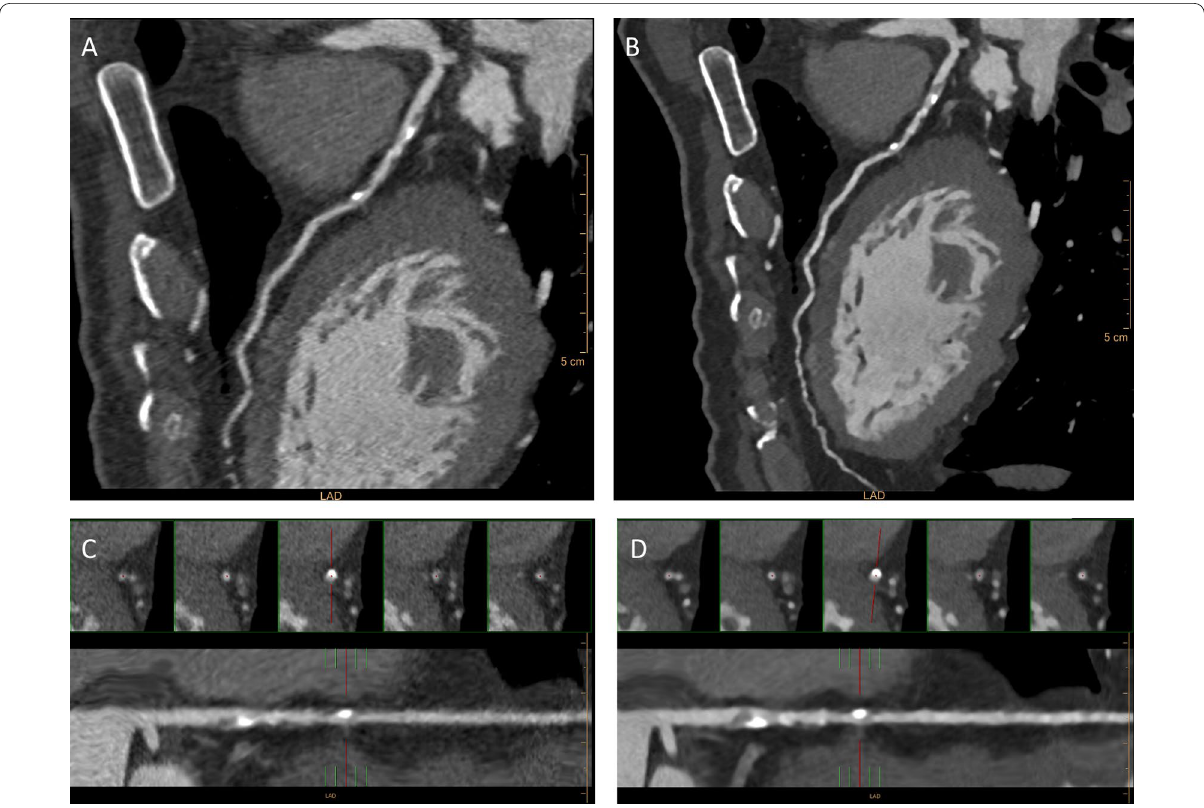
Fig. 4 Evaluation of left anterior descending coronary artery of a single patient with both IR ( a and c) and MBIR ( b and d) reconstruction algorithm. The MBIR reconstruction better depicts the artery wall and the lesions in comparison with IR images because of lower image noise. a–b Curved reconstruction of the LAD artery showing multiple mixed atherosclerotic plaques in the proximal and intermediate tract. New model-based iterative reconstruction (MBIR) is also possible to evaluate the distal tract of the coronary artery analyzed. c–d Straight reconstructions of IR ( c ) and MBIR ( d ) images for a better evaluation of proximal atherosclerotic plaque, which determined luminal stenosis of 65–70% described as CAD-RADS